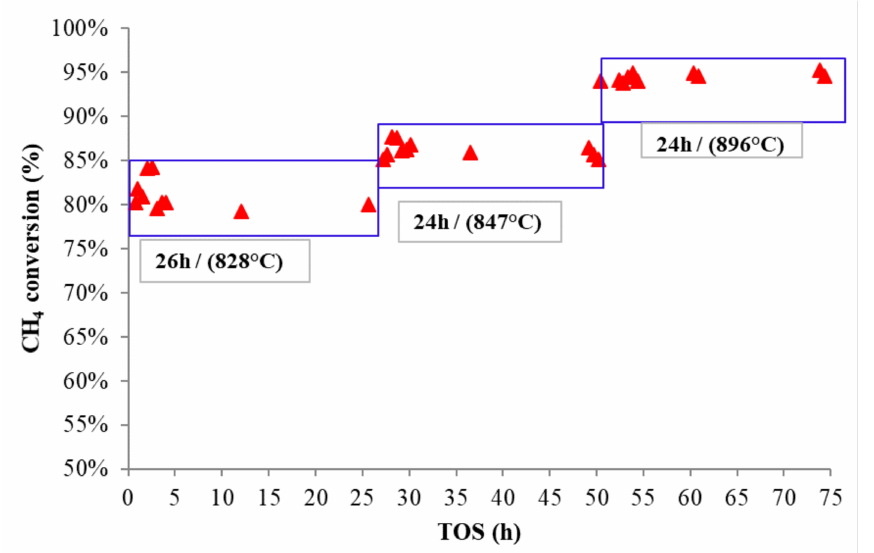
Figure 11. Catalytic performances of Ni-UGSO on mixed methane dry and steam reforming (CO 2 /CH 4 = 0.97 and H 2 O/CH 4 =